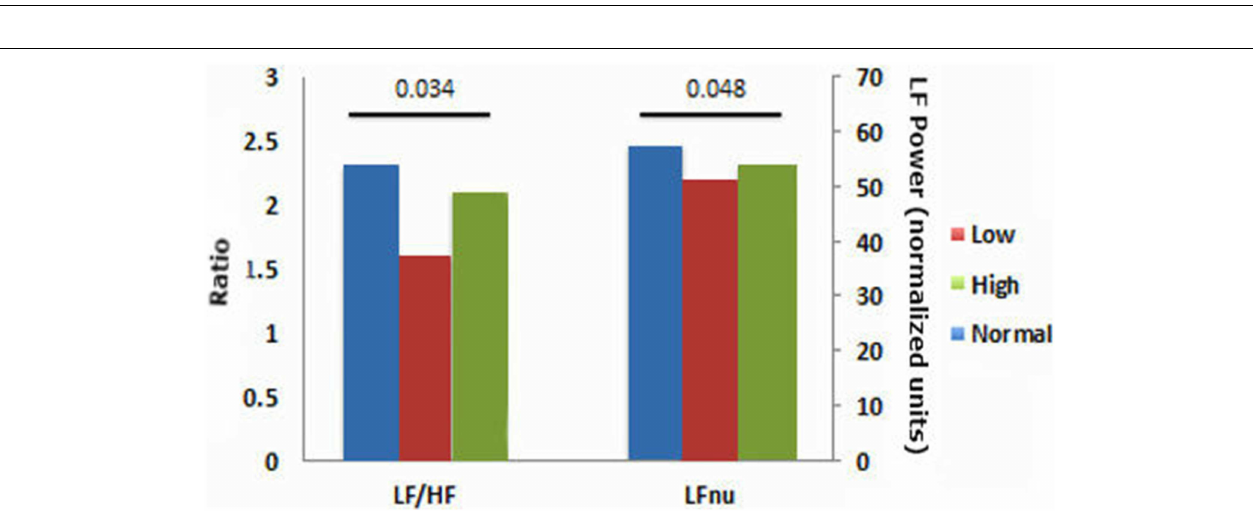
FIGURE 2 | Nonlinear HRV for normal, low and high APBI centile groups.